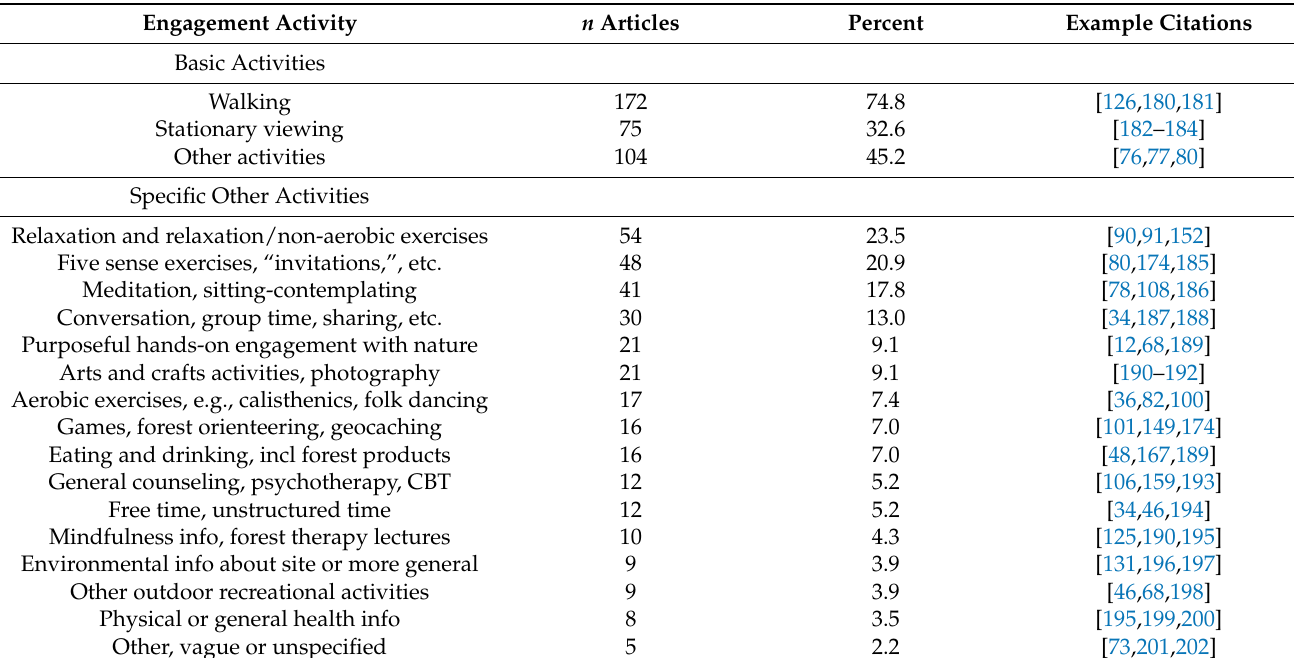
Table 7. Major engagement activity and other specific activities engaged in by forest therapy partici- pants ( n = 230 articles